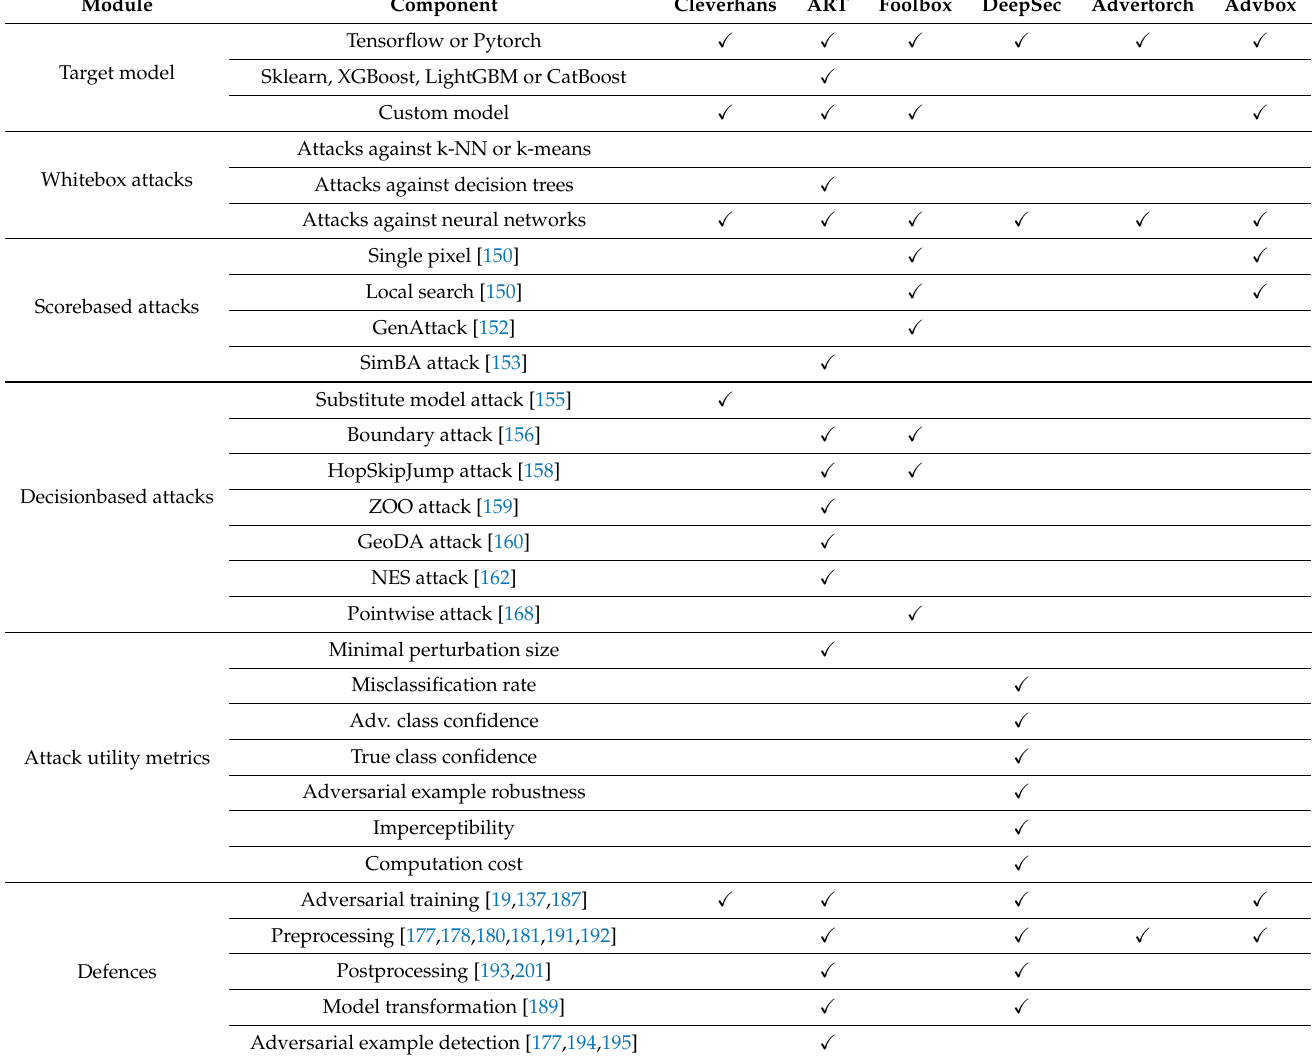
Table 4. Frameworks for adversarial example